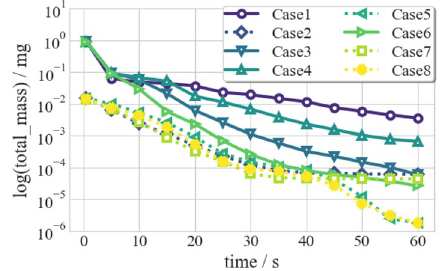
Figure 22. Total mass of airborne droplets varies with time.